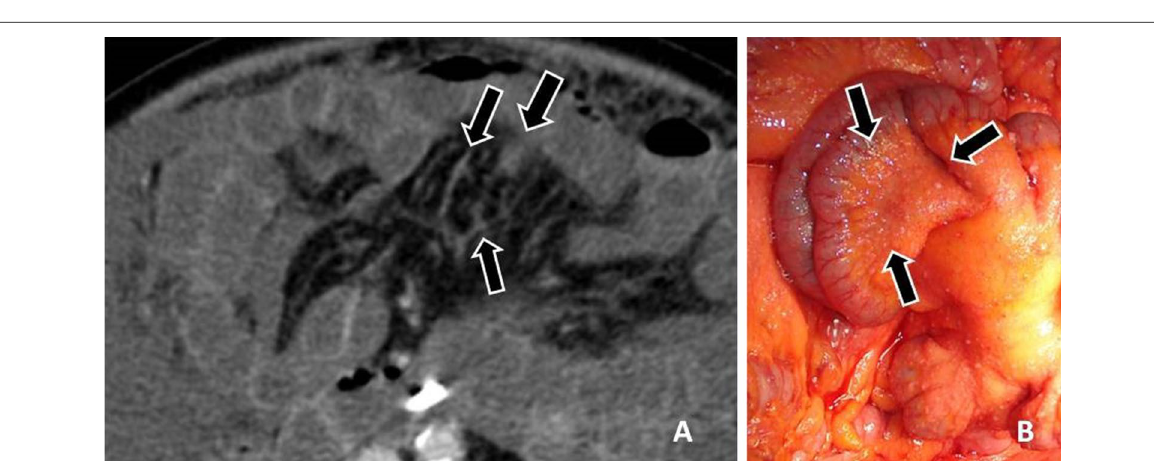
Fig. 13 a CT enteroclysis image shows thickening of the mesenteric surface (arrows) and distortion and thickening of the fatty mesenteric folds. b At surgery multiple small implants on the mesentery are revealed (arrows)